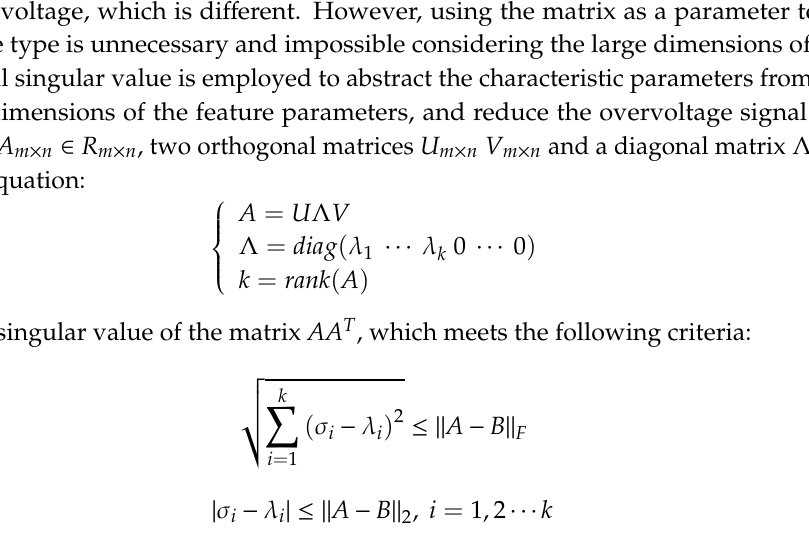
Figure 10 indicates the module value of the S-transform matrix of the zero-sequence voltage signal of the induced lightning overvoltage, switching-o ff idle transformer overvoltage, and switching capacitors overvoltage, which is di ff erent. However, using the matrix as a parameter to recognize the overvoltage type is unnecessary and impossible considering the large dimensions of the matrix.